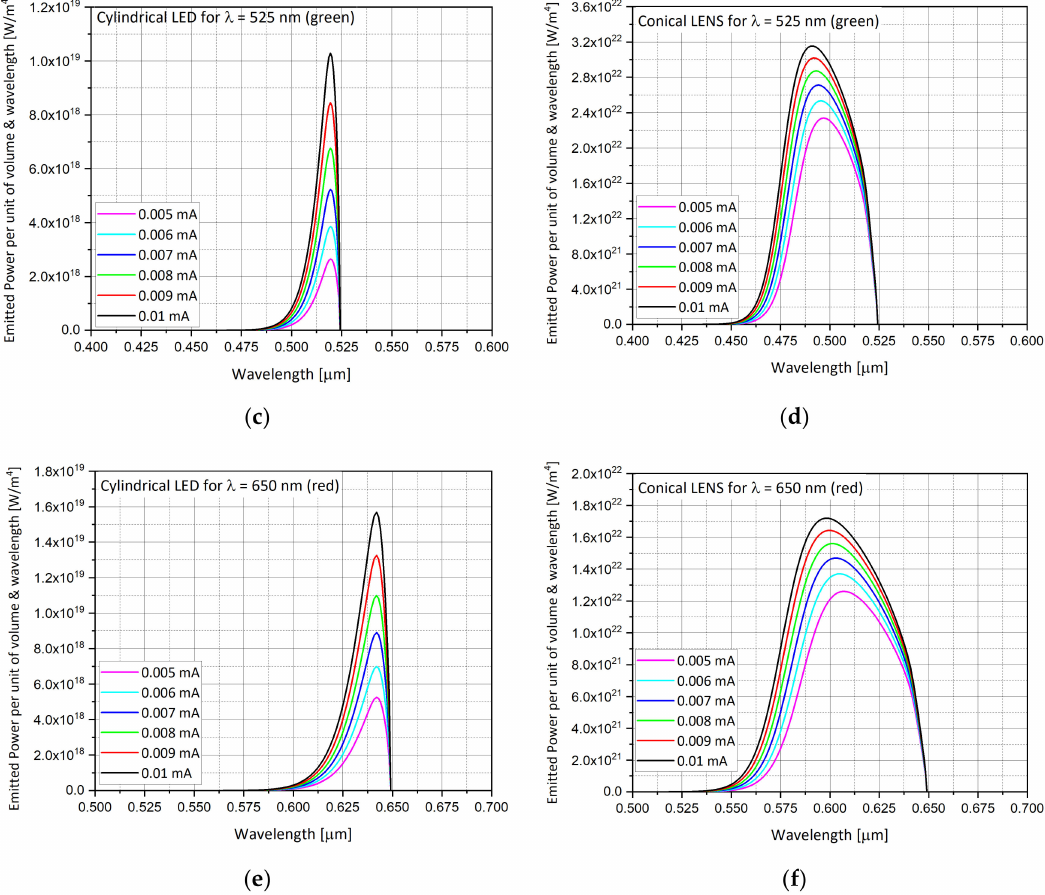
Figure 10. Emission spectra obtained from the InGaN layer. ( a ) LED, λ = 450 nm (blue); ( b ) LENS, λ = 450 nm (blue); ( c ) LED, λ = 525 nm (green); ( d ) LENS, λ = 525 nm (green); ( e ) LED, λ = 650 nm (red); ( f ) LENS, λ = 650 nm (red).